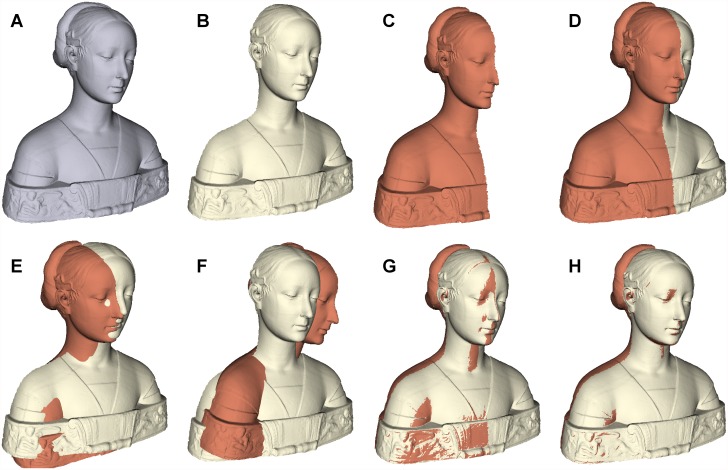
Registration of shapes having partial overlap. (Experiment 7).(A): The statue Laurana sub-divided into (B): front and (C): right half-sections, such that (D): a 50% overlap exists between the two sub-shapes. The sub-shapes were (E): misaligned by 10 mm and 10 degrees in a random direction and then registered using (F): CPD [20], (G): GICP [11], and (H): the proposed IMLP algorithm. Sub-figures (E-H) show the initial misalignment and the final registered alignments of the two shapes for the 6th randomized trial of Experiment 7, which involved 10 randomized trials in total.